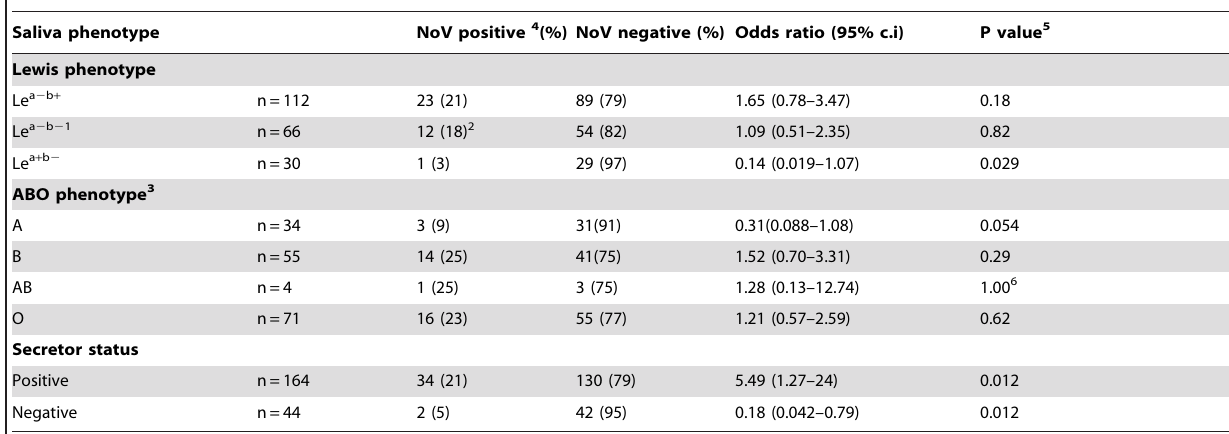
Table 3. Host genetic factors and association to susceptibility to NoV infections in Burkina Faso.